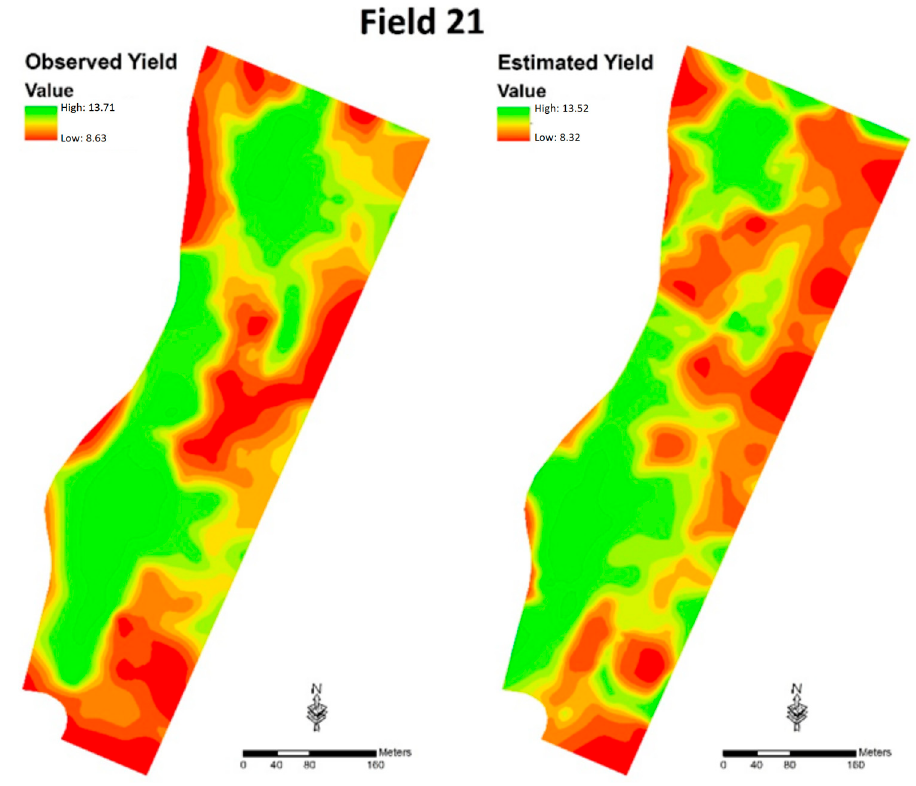
Figure 6. Predicted yield map generated based on the spatial global meta-function (SPL) for field (F21) that present spatial autocorrelation versus end-season yield monitor data.